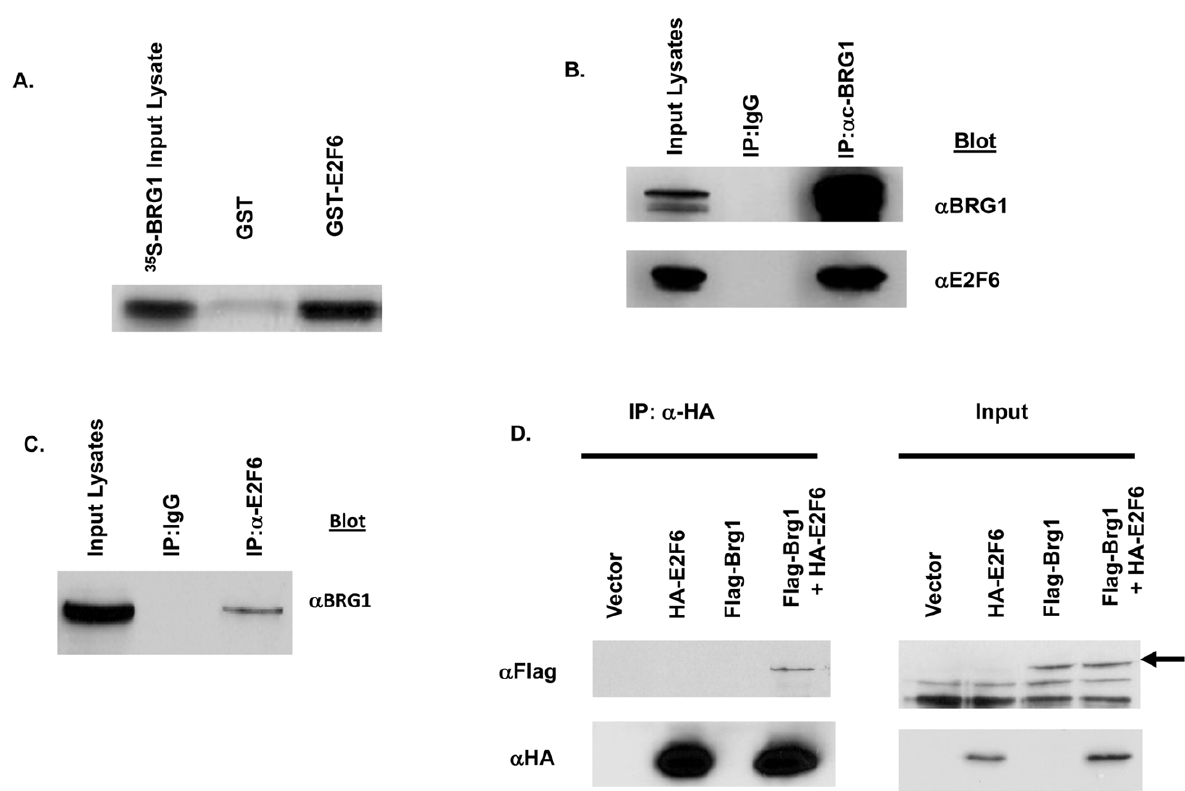
Figure 1. E2F6 interacts with BRG1. A) A GST-E2F6 recombinant protein directly interacts with in vitro -translated BRG1 proteins. GST-E2F6 recombinant proteins generated in E-coli were immobilized on glutathione S-transferase (GST)-Sepharose beads and incubated with S 35 -labeled in vitro -translated BRG1 proteins. E-coli expressed GST protein was used as a control. Beads were washed in TBS/Triton X-100 after four hours, resuspended in 2 X Laemelli’s buffer and resolved on a 6% SDS PAGE gel. B) BRG1 coimmunoprecipitates with E2F6 proteins. Plasmid constructs overexpressing BRG1 and E2F6 were co-transfected into T98G cells. Immunoprecipitations were performed with a monoclonal antibody recognizing BRG1. Immunoprecipitates were resolved on SDS PAGE and assayed by Western blotting with polyclonal antibodies recognizing BRG1 or E2F6. C) Endogenous E2F6 and BRG1 proteins coimmunoprecipitates. Asynchronously growing 293 cells were collected in lysis buffer. Immunopreciptations were performed with a polyconal antibody recognizing E2F6. Immunoprecipitated proteins were resolved on SDS PAGE and assayed by Western blotting with a monoclonal antibody recognizing BRG1. D) HA-tagged E2F6 interacts with flag-tagged BRG1. Plasmid constructs overexpressing epitope-tagged versions of E2F6 and BRG1 were individually transfected or cotransfected into 293 cells. Immunoprecipitations were carried out with a polyclonal antibody recognizing the HA epitope tag on E2F6. Immunoprecipitates were resolved on SDS PAGE and Western blotted with the monoclonal M2 anti-flag